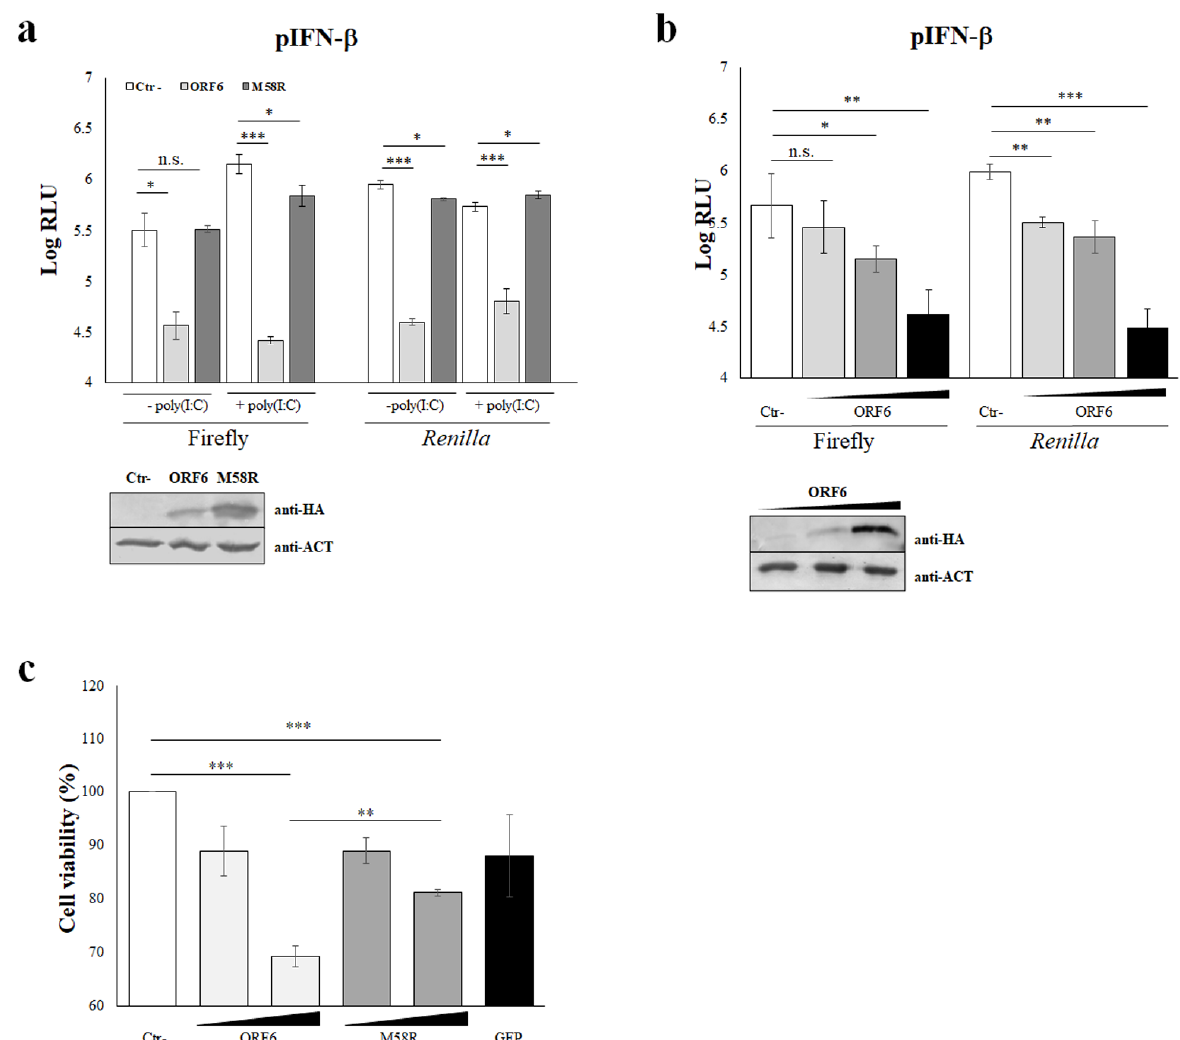
Figure 1. Inhibitory activity of SARS-COV-2 ORF6 protein. ( a ) HEK-293T cells were co-transfected with the IFN-β promoter-mediated firefly luciferase (pIFN-β) and the SV40 promoter-mediated Renilla luciferase reporter plasmids, with ORF6 or the mutant M58R expressing plasmids or with empty vector (Ctr-). At 36 h post-transfection, cells were left unstimulated or poly(I:C)-stimulated by transfection. Firefly and Renilla luciferase activities were estimated with respect to the relative control sample at 48 h post-transfection. Three ( n = 3) independent experiments were performed and representative data are presented as mean logarithm values of relative luminescence unit (RLU) ± standard deviations (SD). Original blots are presented in Supplementary Materials. ( b ) Luciferase assay conducted in HEK-293T cells transfected with increasing ORF6 (wedge represents increasing amount of the expression vectors: 10, 100, and 500 ng) or empty vector (Ctr-), together with the pIFN-β and the SV40 promoter-mediated Renilla luciferase as the internal control. Data are pre- sented as mean logarithm RLU values ± SD and are one representative of four independent experi- ments. ( c ) HEK-293T cells were co-transfected with increasing amounts (10 ng and 500 ng) of ORF6 or M58R expressing plasmids, with 500 ng of green fluorescent protein (GFP) expressing plasmid or with empty vector (Ctr-). Cell viability was evaluated at 48 h post-transfection by MTT assay. Three ( n = 3) independent experiments were performed and representative data are presented as mean percentage of cell viability ± standard deviations (SD). ( a – c ) Significance was determined us- ing unpaired, two-tailed Student’s t -test *** p < 0.0005, ** p < 0.005, * p < 0.05, n.s = not significant). Subsequently, pIFN-β activation was evaluated after poly(I:C)-stimulation, confirm- ing the marked antagonistic activity of the wt-ORF6 protein on IFN-β expression, leading to a 50-fold ( p = 0.0001; ***) reduction in firefly reporter values (Figure 1a). On the contrary,